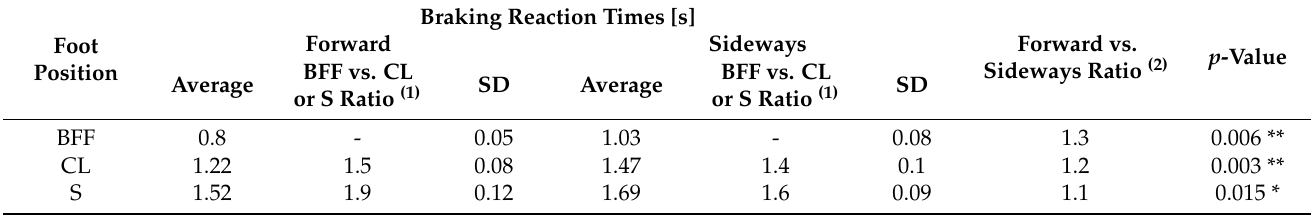
Table 3. Braking reaction times.